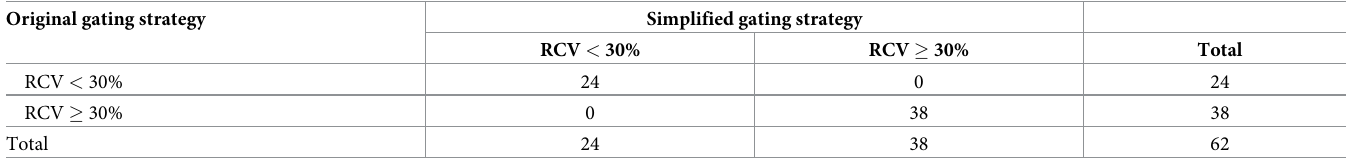
Abbreviations: RCV = robust coefficient of